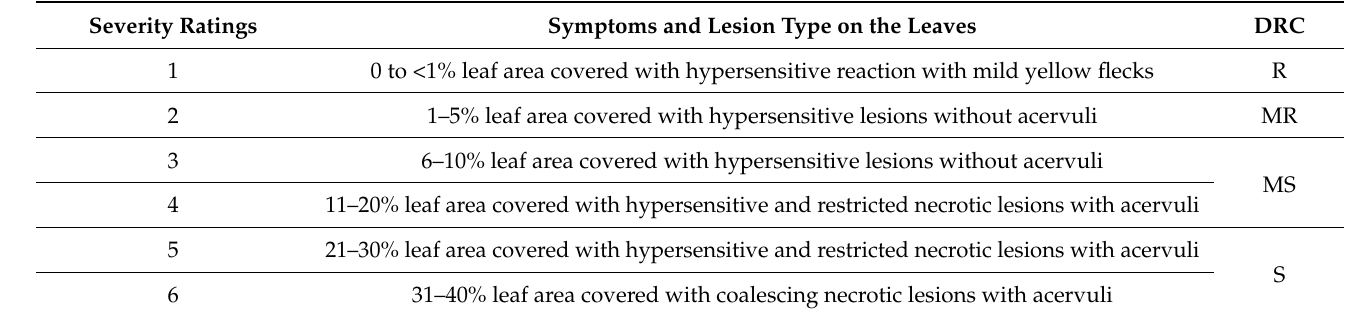
Table 1. Assessment scale of anthracnose disease against sorghum plants under greenhouse conditions. Symptoms and Lesion Type on the Leaves